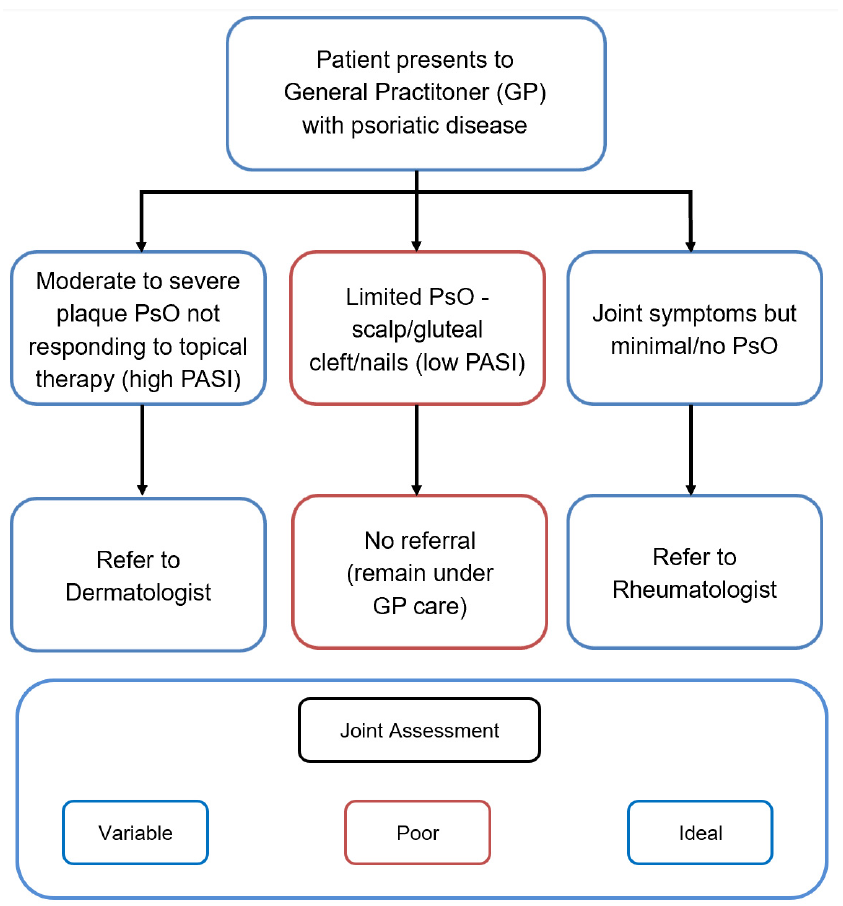
Figure 2. Current practice for psoriatic disease referral to secondary care in the United Kingdom. PsO: Psoriasis; PASI: Psoriasis Area Severity Index.